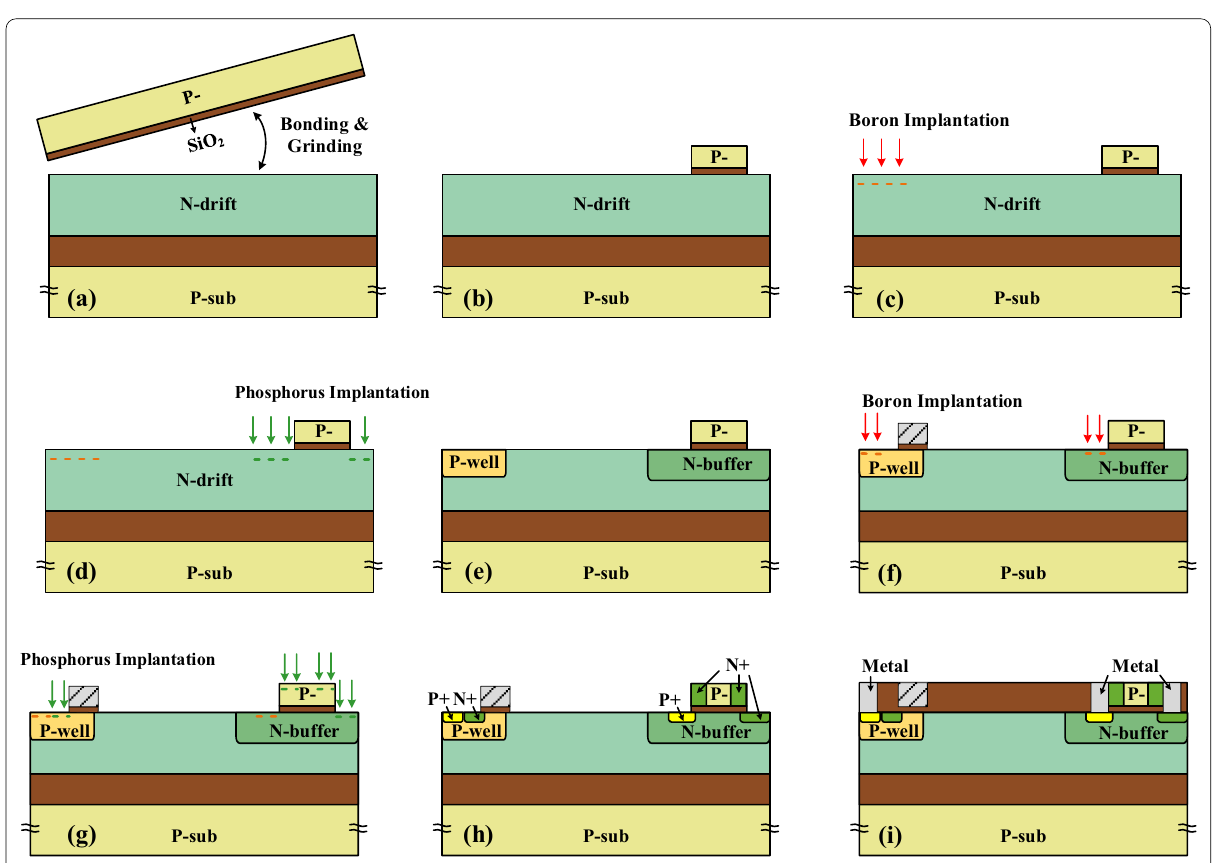
Fig. 14 Key process steps to fabricate the ISM LIGBT. a Bonding and grinding, b part SOI region etching, c boron implantation of P-well, d phosphorus implantation of N-buffer, e anneal, f form the gate structure and boron implantation to form P to form N contact, h rapid thermal anneal, i formation of +